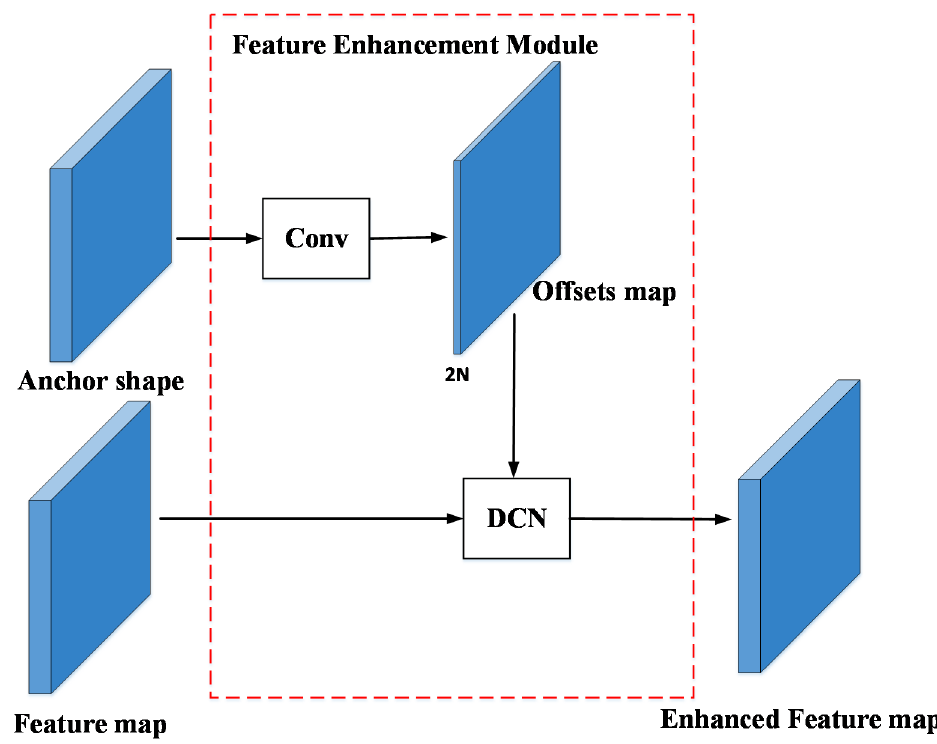
Figure 4. Illustration of the feature enhancement module.